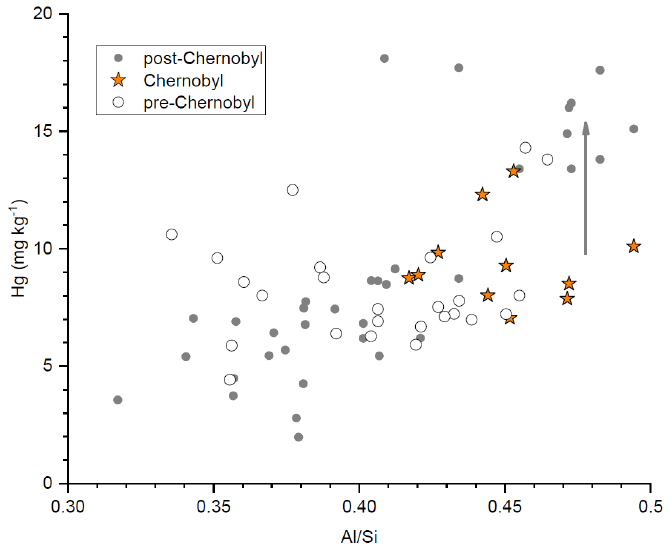
Figure 6. Dependence of Hg concentration on Al/Si ratio. Gray arrow shows the main trends above the Chernobyl